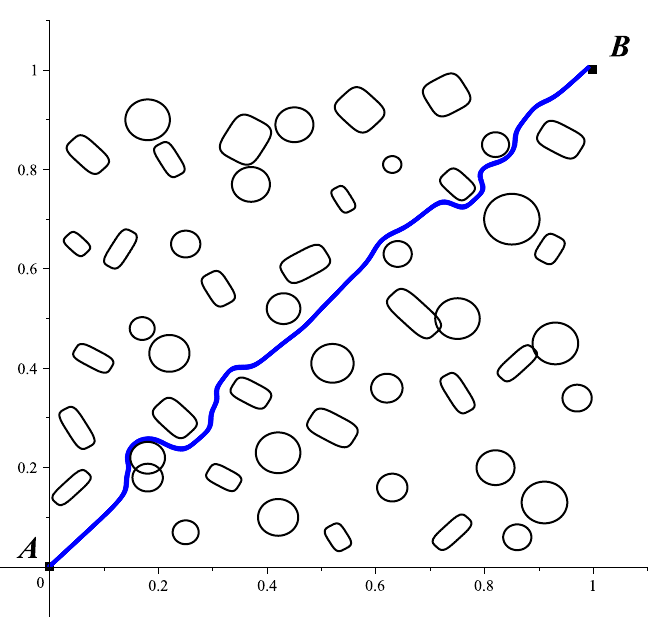
Figure 17. Example containing 50